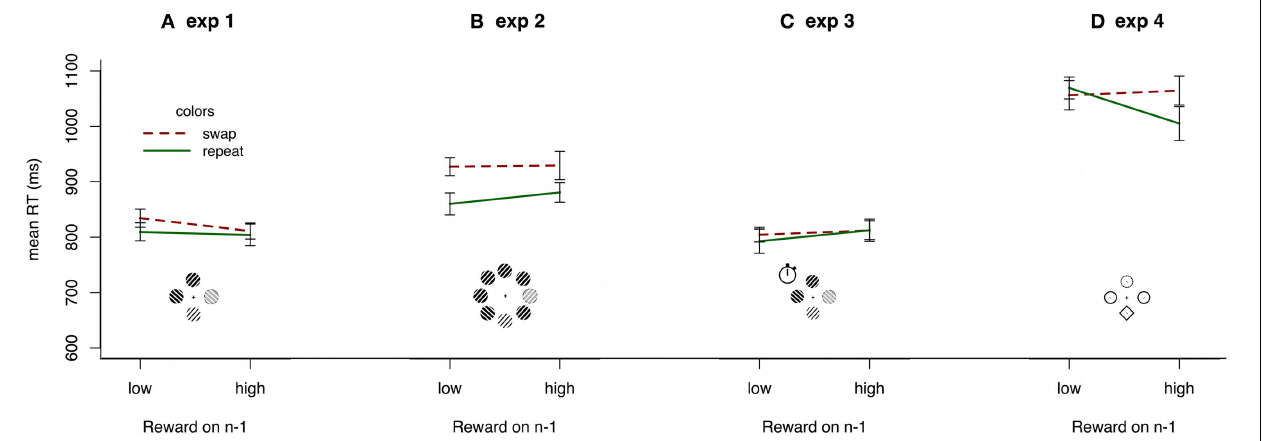
set-sizes in each experiment (not drawn to scale; see Methods for details). Error bars show within-subject 95% confidence intervals (Cousineau,